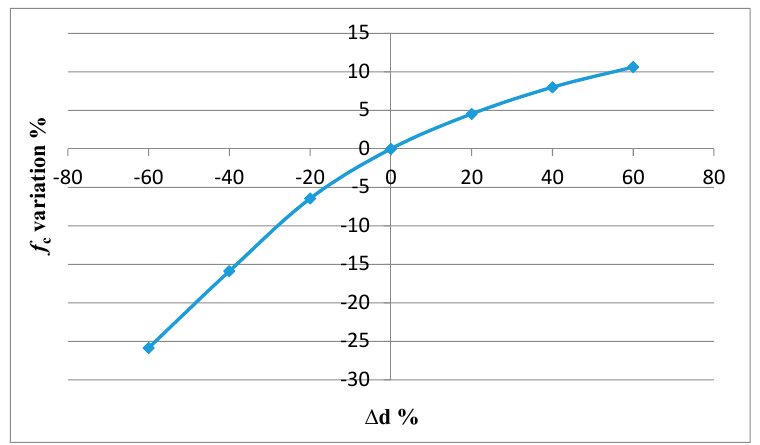
Figure 17. Sensitivity of diameter reduction vs. f n .